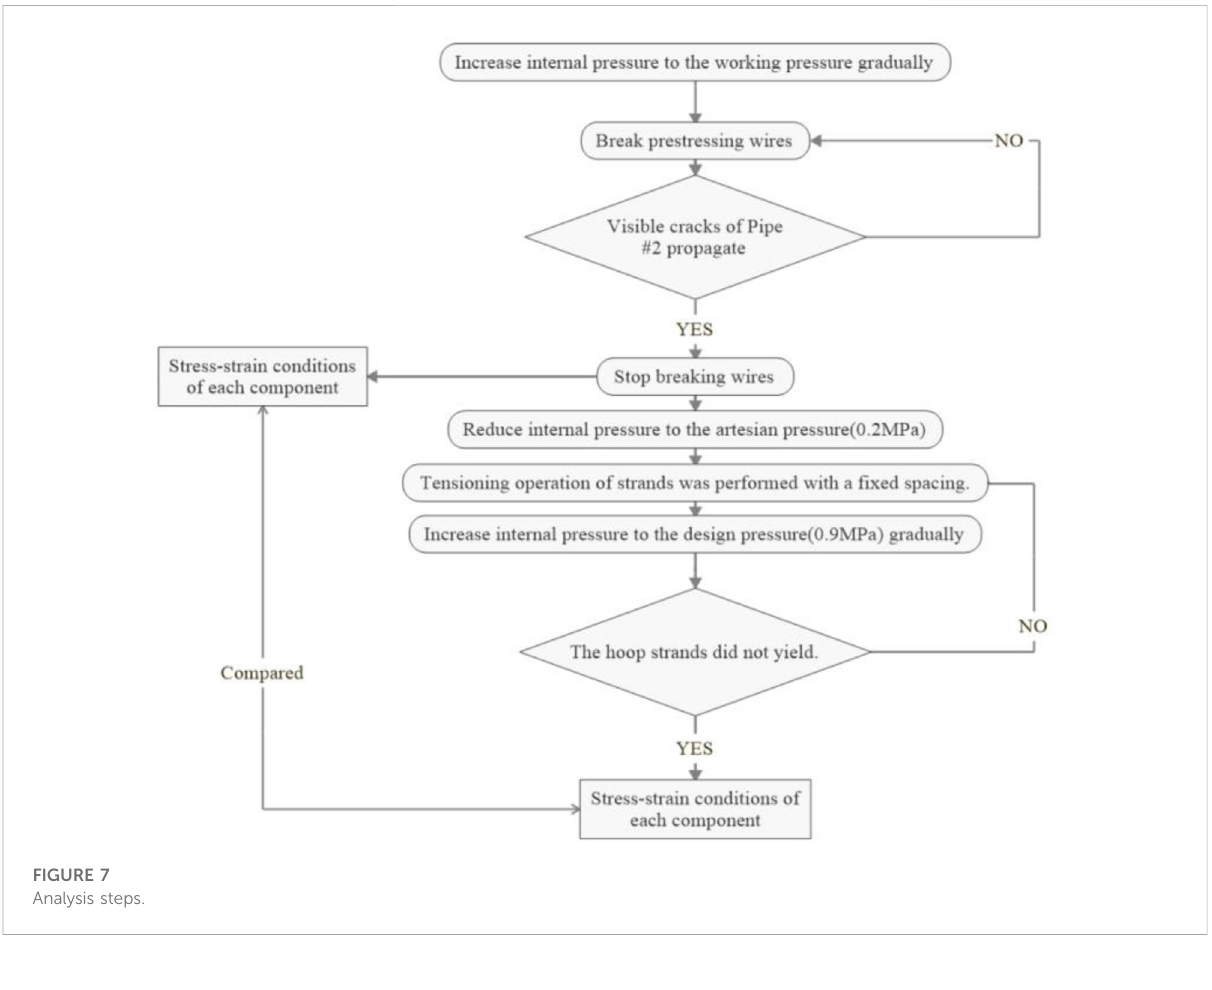
FIGURE 8 Details of the test